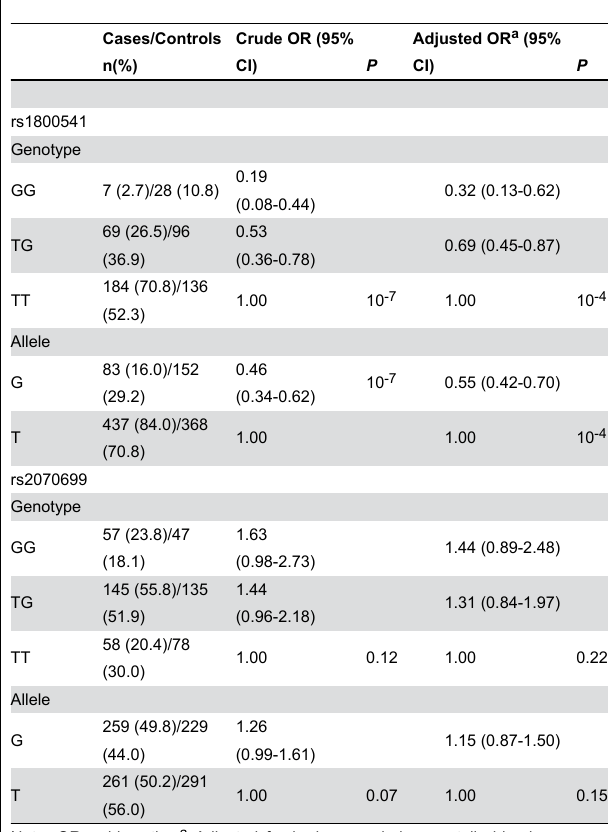
Table 2. Hardy-Weinberg Equilibrium (HWE) Test on Controls in the Study.